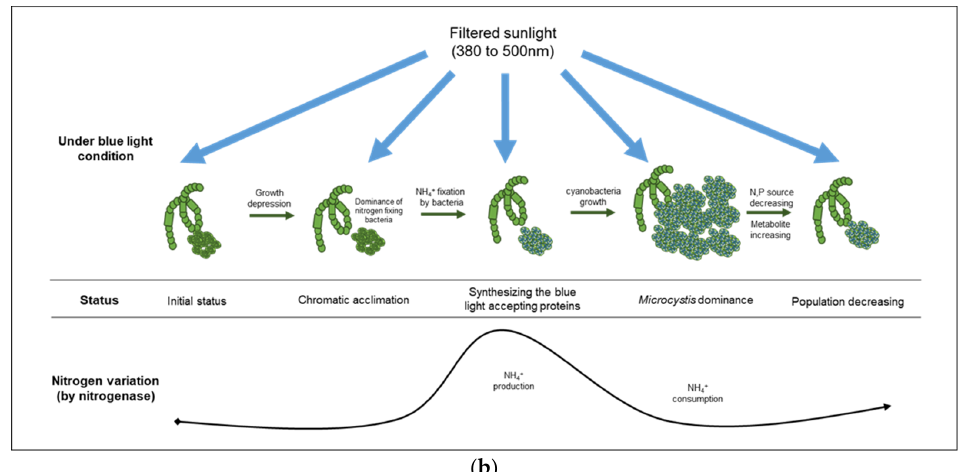
Figure 6. Comparison of cyanobacterial growth patterns under natural ( a ) and blue light-filtered ( b ) conditions. It was elucidated that a plausible interaction exists between cyanobacteria and their associated bacterial assemblages through nitrogenous metabolites.